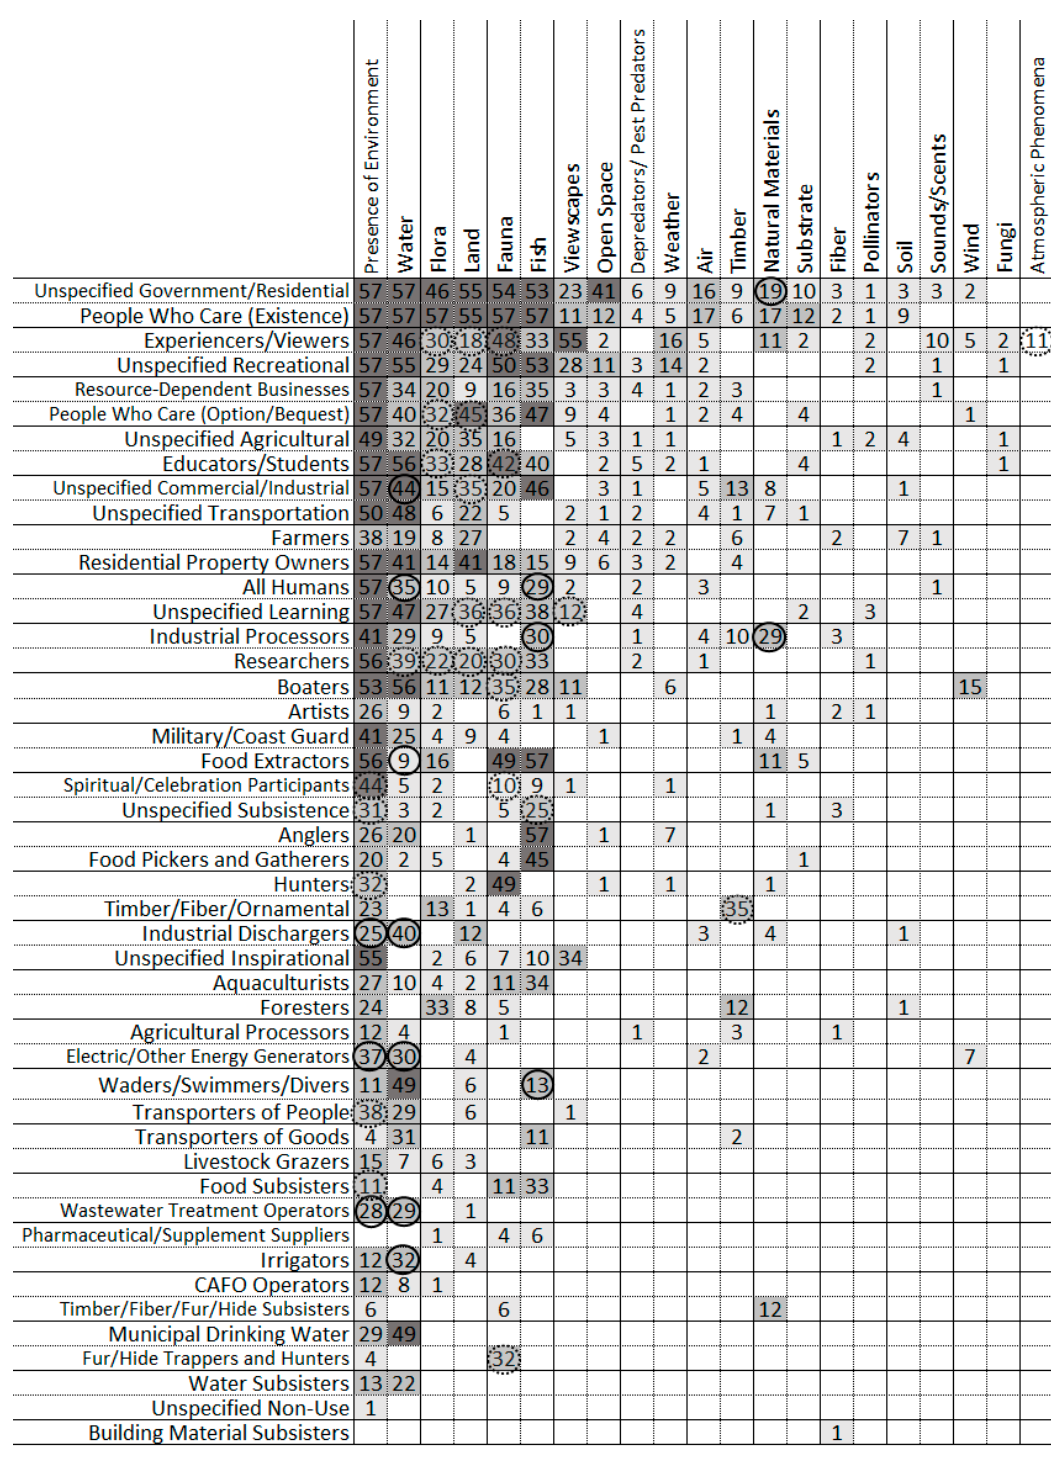
Figure 5. Number of management plans mentioning each type of FEGS with each category of Beneficiary. Circles indicate a particular combination was significantly (logistic regression; p < 0.05) more common in either NEP plans (solid) or NERR plans (dashed).